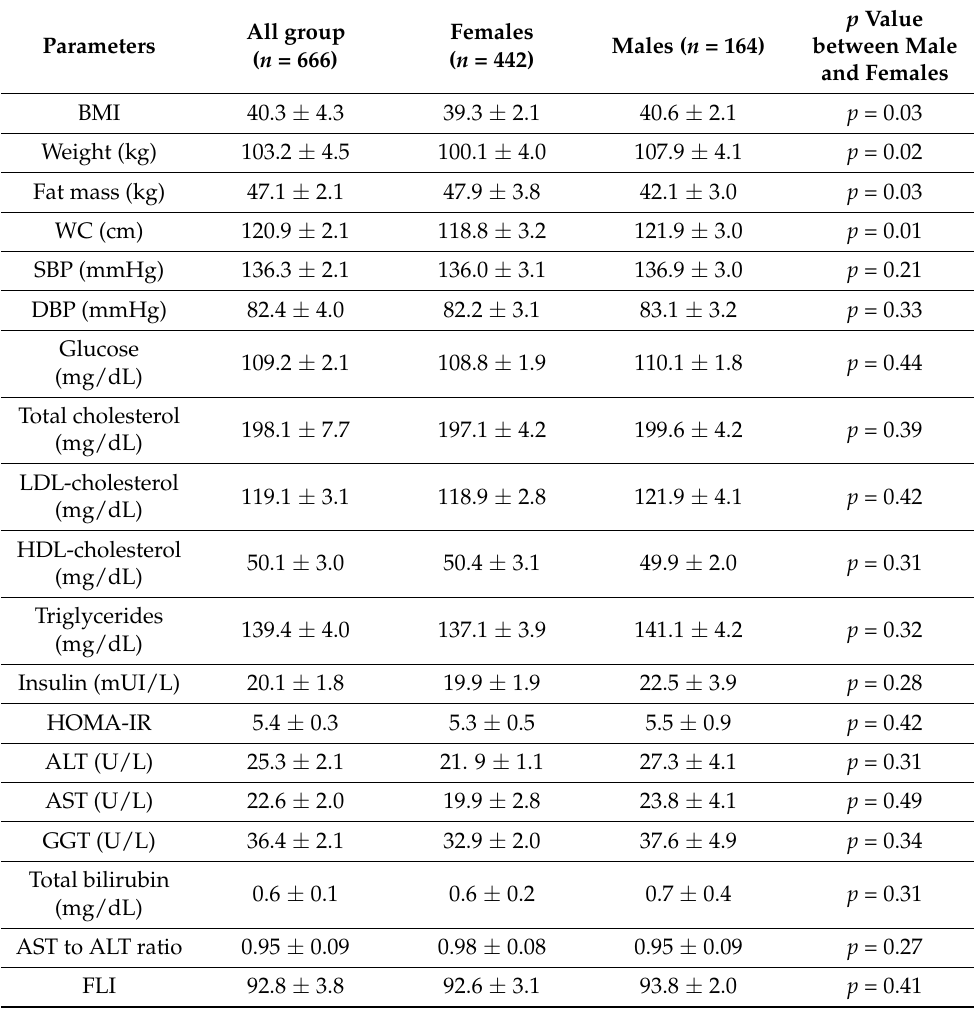
Table 2. Anthropometric parameters and blood pressure at baseline time (mean ± standard deviation) at basal